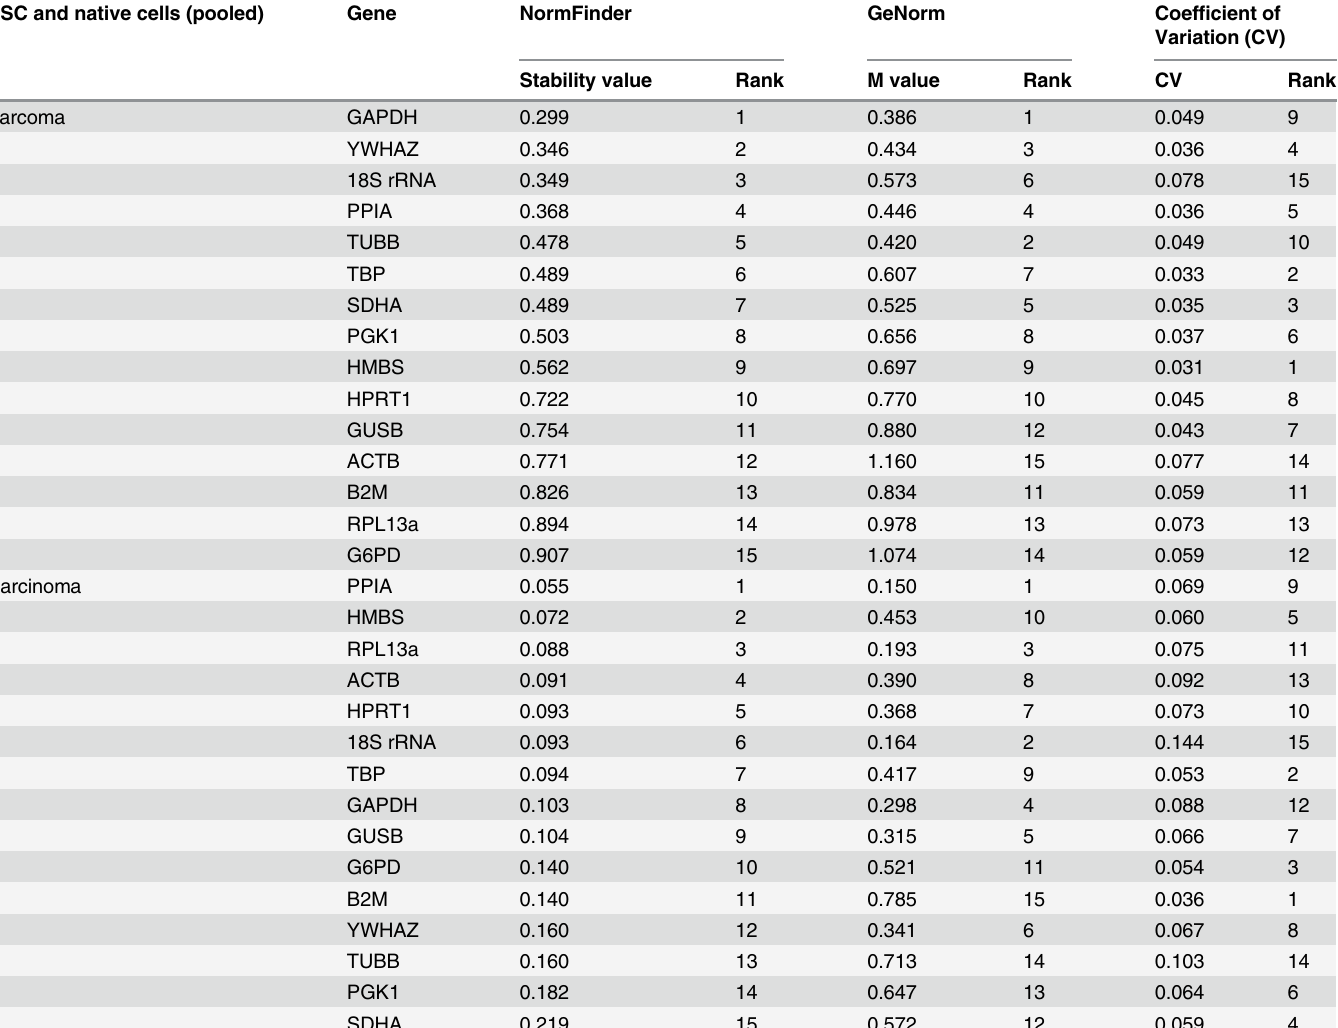
Table 5. Ranking of the stability of the expression of candidate reference genes by NormFinder, geNorm, and CV analyses in CSC and native cells from carcinoma and sarcoma tumors. CSC and native cells (pooled)